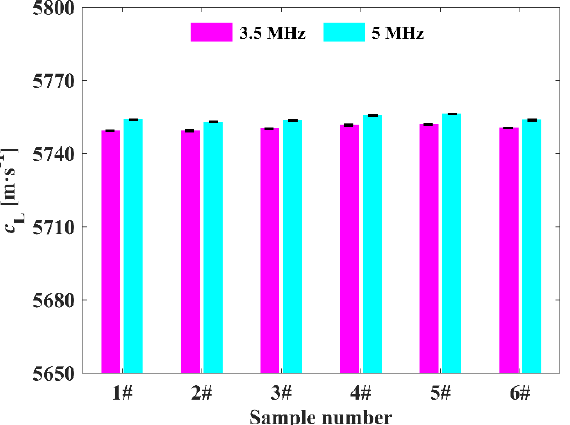
Figure 5. 𝑐 (cid:2896) measurement results of the ULE samples 1#~6# at frequencies of 3.5 and 5 MHz. Figure 5. c L measurement results of the ULE samples 1#~6# at frequencies of 3.5 and 5